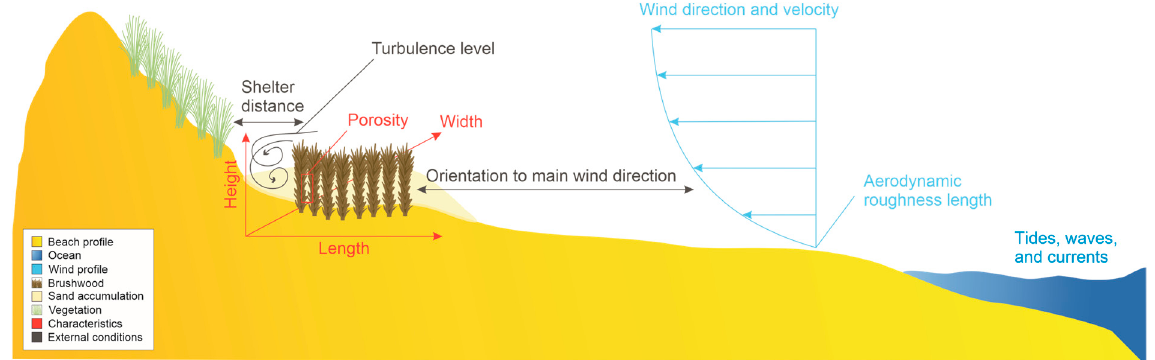
Figure 5. Fence characteristics and wind conditions influencing aerodynamic and morphodynamic properties around a single porous sand trapping fence.